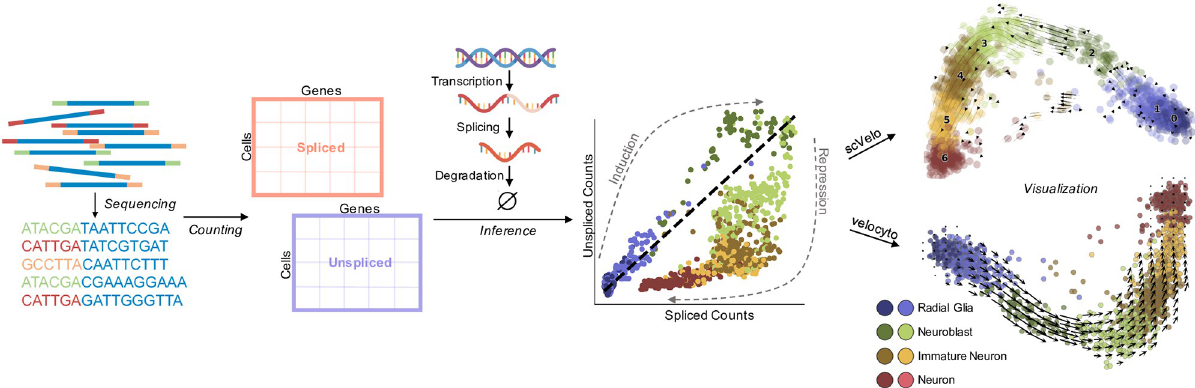
Fig 1. A summary of the user-facing workflow of a typical RNA velocity workflow. Initial processing of sequencing reads produces spliced and unspliced counts for every cell, across all genes. Inference procedures, implemented in velocyto and scVelo , fit a model of transcription, and predict cell- level velocities. The final embedding of cells and smoothed velocities is displayed in the top two principal component dimensions. Visualizations adapted from [25, 26]; dataset from [1]. The DNA and RNA illustrations are derived from the DNA Twemoji by Twitter, Inc., used under CC-BY 4.0.